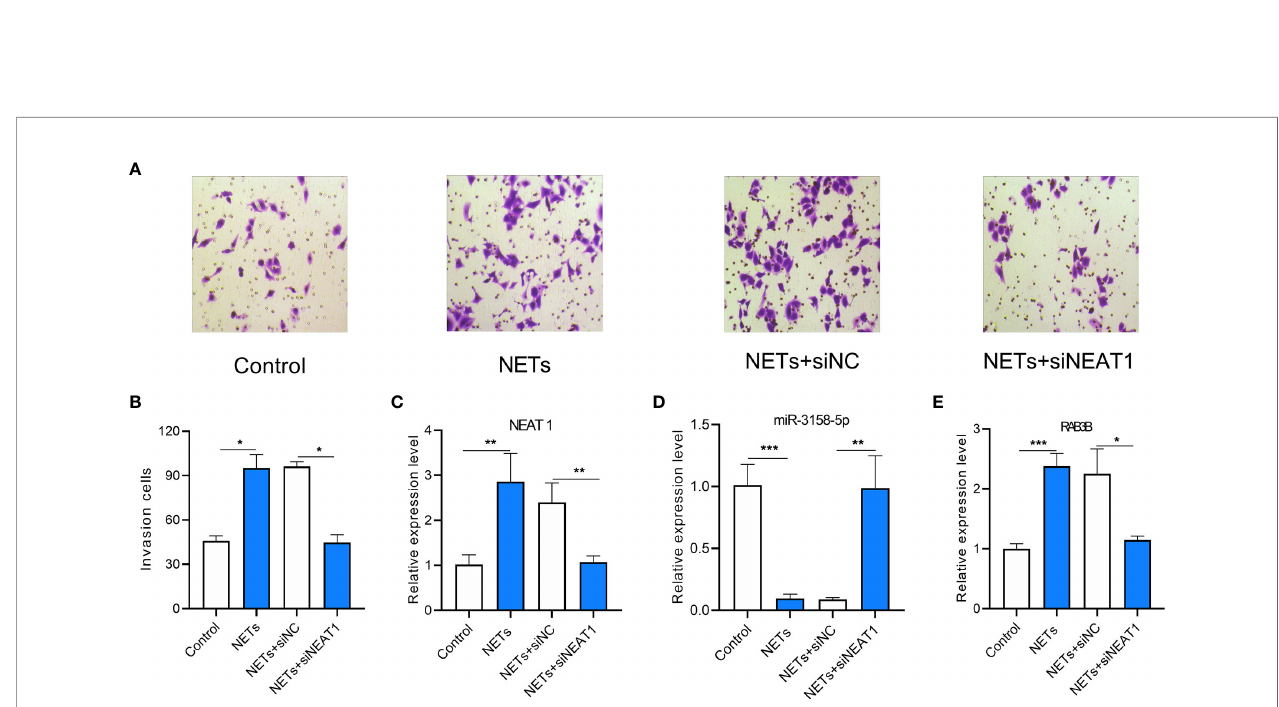
FIGURE 8 | The effect of lncRNA NEAT1 knockdown on invasion of gastric cancer (GC) and miR-3158-5p/RAB3B expression in gastric cancer cells stimulated by NETs. (A) Representative images of Transwell invasion assay. (B) The analysis results of invasive AGS cells treated by NETs and knockdown of lncRNA NEAT1. (C) The expression of lncRNA NEAT1 in AGS cells. (D) The expression of miR-3158-5p in AGS cells. (E) The expression of RAB3B in AGS cells. For Panels (A, B) n = 8, * p < 0.05, for panels C – E, n = 3, * p < 0.05, ** p < 0.01, *** p <